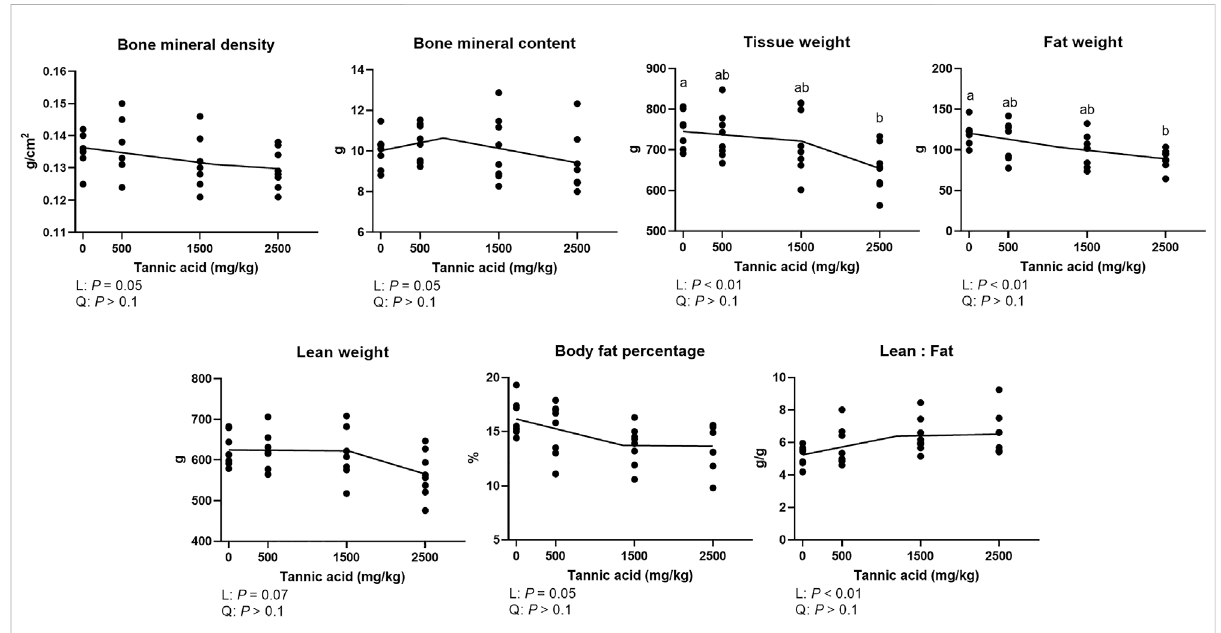
FIGURE 7 Bonemineraldensity (g/cm 2 ),bone mineral content (g),tissueweight(g),fat weight (g),lean weight (g),body fat percentage (%), and lean:fat(g/ g) in broiler chickens fed different concentrations (0, 0.5, 1.5, and 2.5 g/kg) of tannic acid on D 21. The treatment groups were compared using one- way ANOVA followed by the Tukey ’ s multiple comparison. Different superscripts differ at p < 0.05. Orthogonal polynomial contrasts analysis was conducted to see linear pattern (L) and quadratic pattern (Q) among the treatments. To calculate the optimal dosage of tannic acid in broilers, segmented linear regression was conducted, and X0 (in fl ection point) with p values for slope 1 (lower than X0 ) and slope 2 (higher than X0 ) were presented.